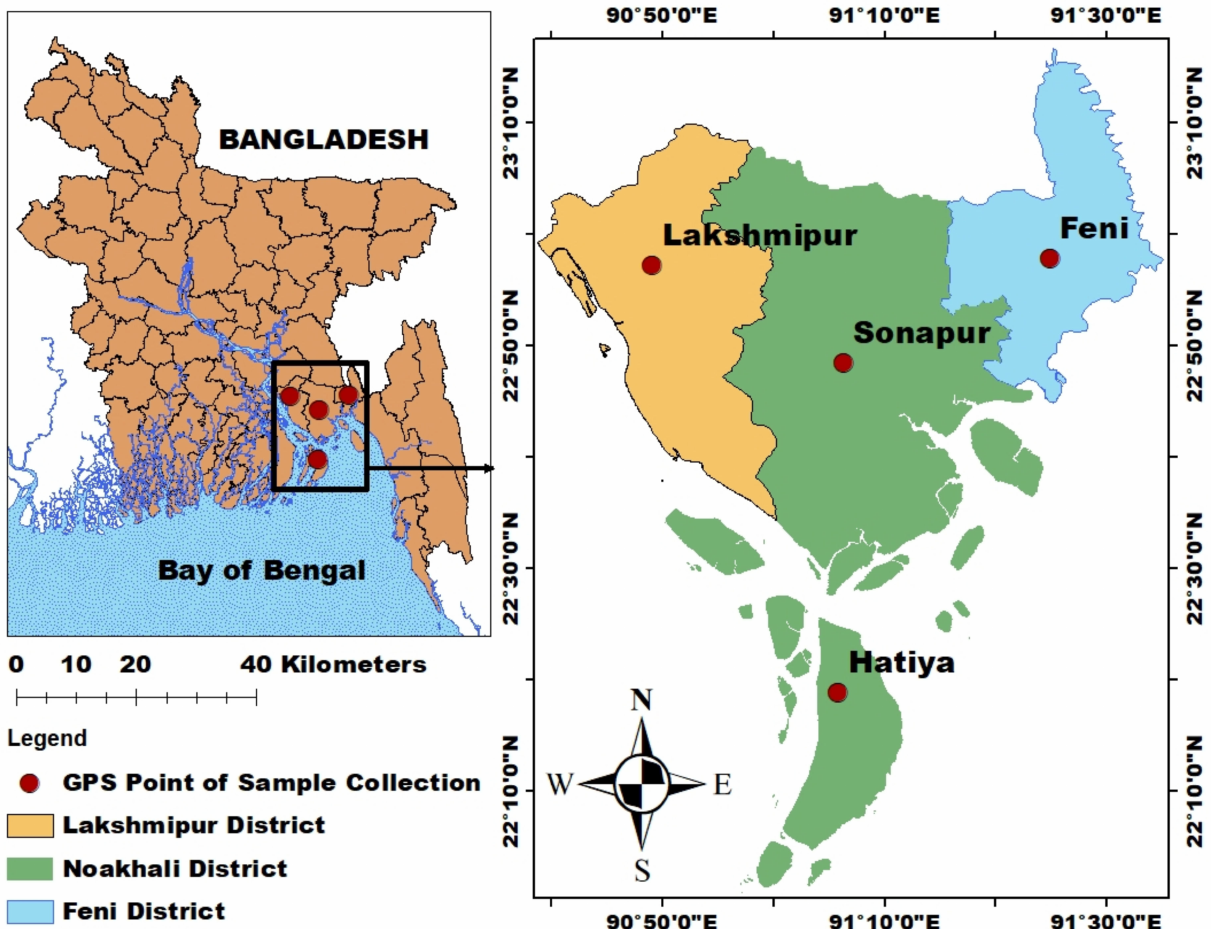
Figure 1. Sampling locations along the northern Bay of Bengal